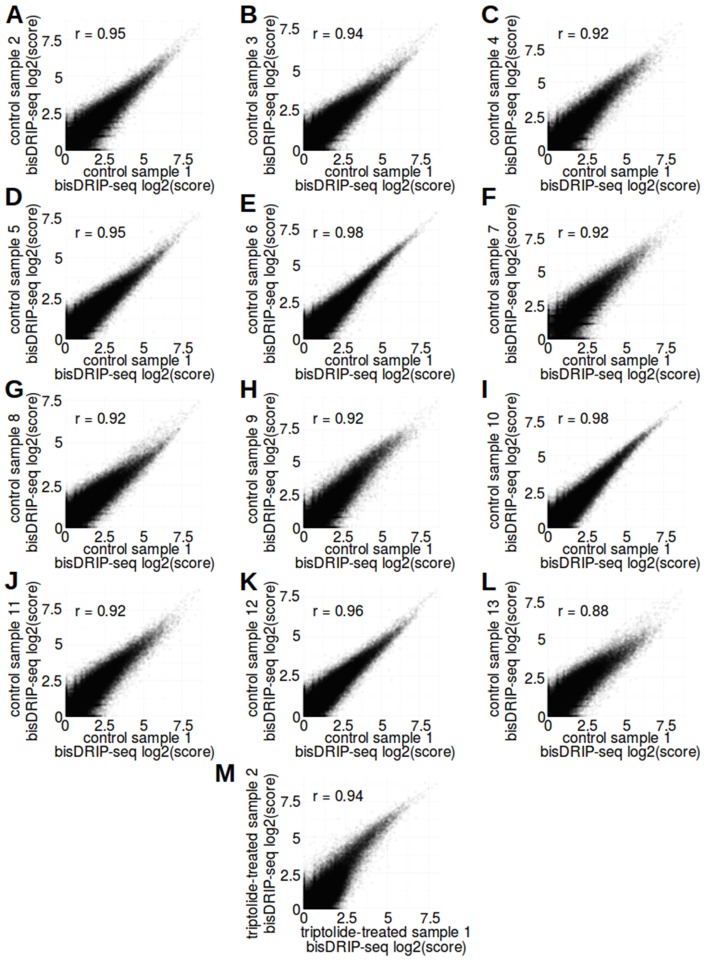
bisDRIP-seq scores of promoter regions were correlated between samples.(A–L) bisDRIP-seq scores of promoter regions were reproducible between control-treated samples. In order to examine the level of sample-to-sample variation in control-treated bisDRIP-seq samples, we compared the bisDRIP-seq scores of each promoter region in different control-treated samples. bisDRIP-seq scores were calculated for each promoter region derived from our reference GENCODE transcription start site list (n = 78218). Promoter regions were defined as the region within 1000 bp of a transcription start site. The bisDRIP-seq score for each promoter region was calculated using the sum of the bisDRIP-seq read scores aligned to either strand as described in methods. The log2 of the bisDRIP-seq score for each promoter region in control-treated sample 1 (x-axis) was plotted against the same value generated from each of the other twelve control-treated samples (y-axis). The bisDRIP-seq scores in promoter regions in control-treated sample one were correlated with the bisDRIP-seq scores in promoter regions in each of the other control-treated samples. This suggests that the control-treated bisDRIP-seq experiments were reproducible. Pearson correlation coefficients (r) are indicated in the top-left corner of each plot. (M) bisDRIP-seq scores of promoter regions were reproducible between triptolide-treated samples. In order to examine the level of sample-to-sample variation in triptolide-treated bisDRIP-seq samples, we compared the bisDRIP-seq scores of each promoter region in both of our triptolide-treated samples. bisDRIP-seq scores were calculated as described in (A–L) for control-treated samples. The log2 bisDRIP-seq score for each promoter region (n = 78218) in the triptolide-treated sample 1 (x-axis) was plotted against the same value generated from the triptolide-treated sample 2 (y-axis). The bisDRIP-seq scores in promoter regions were correlated between the two samples. This suggests that our triptolide-treated bisDRIP-seq experiments were reproducible. The Pearson correlation coefficient (r) for this plot is indicated in the top-left corner of the plot.